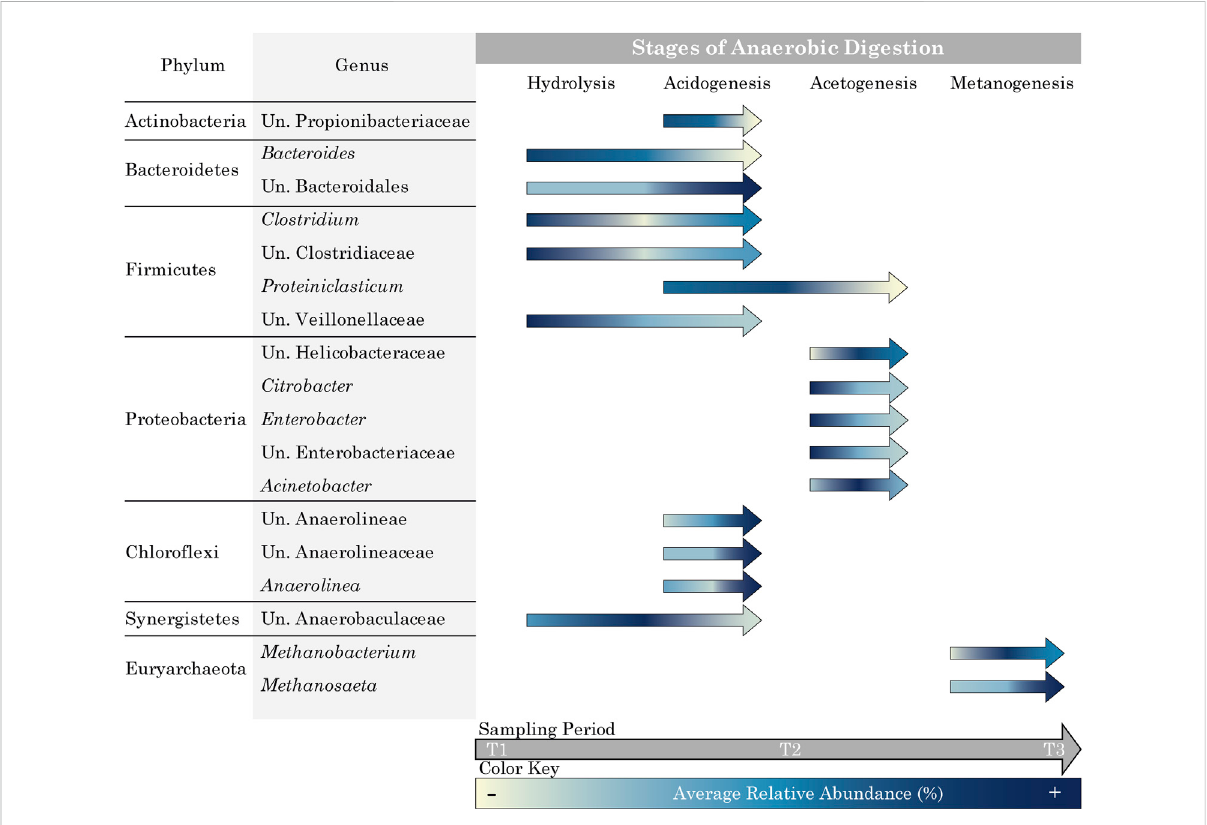
FIGURE 6 Graphical summary of the main genera identi fi ed, the AD stages in which they participate, and the shift in relative abundance from T1 to T3 for each